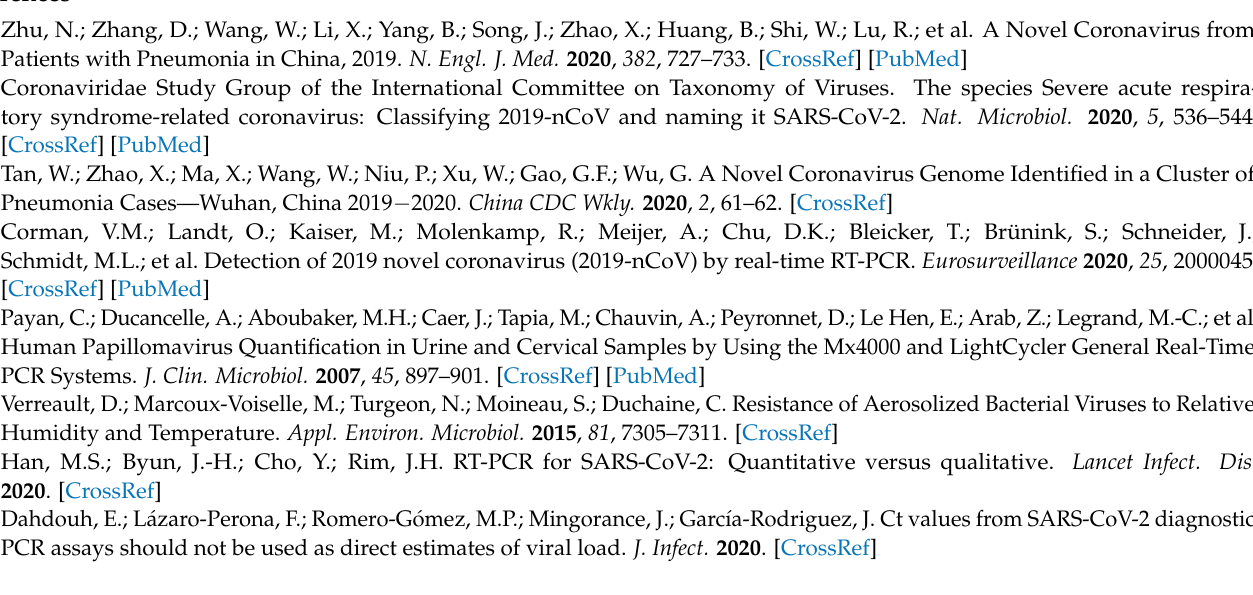
Figure S4: Frequency of SARS-CoV-2 RT-PCR threshold cycle (Ct) values in infected individuals, Table S1: Primer and probe sequences of the laboratory-developed triplex RT-PCRs for detection of SARS-CoV-2, phi 6 phage and GAPDH, Table S2: Specific detection of SARS-CoV-2 RNA by the laboratory-developed triplex